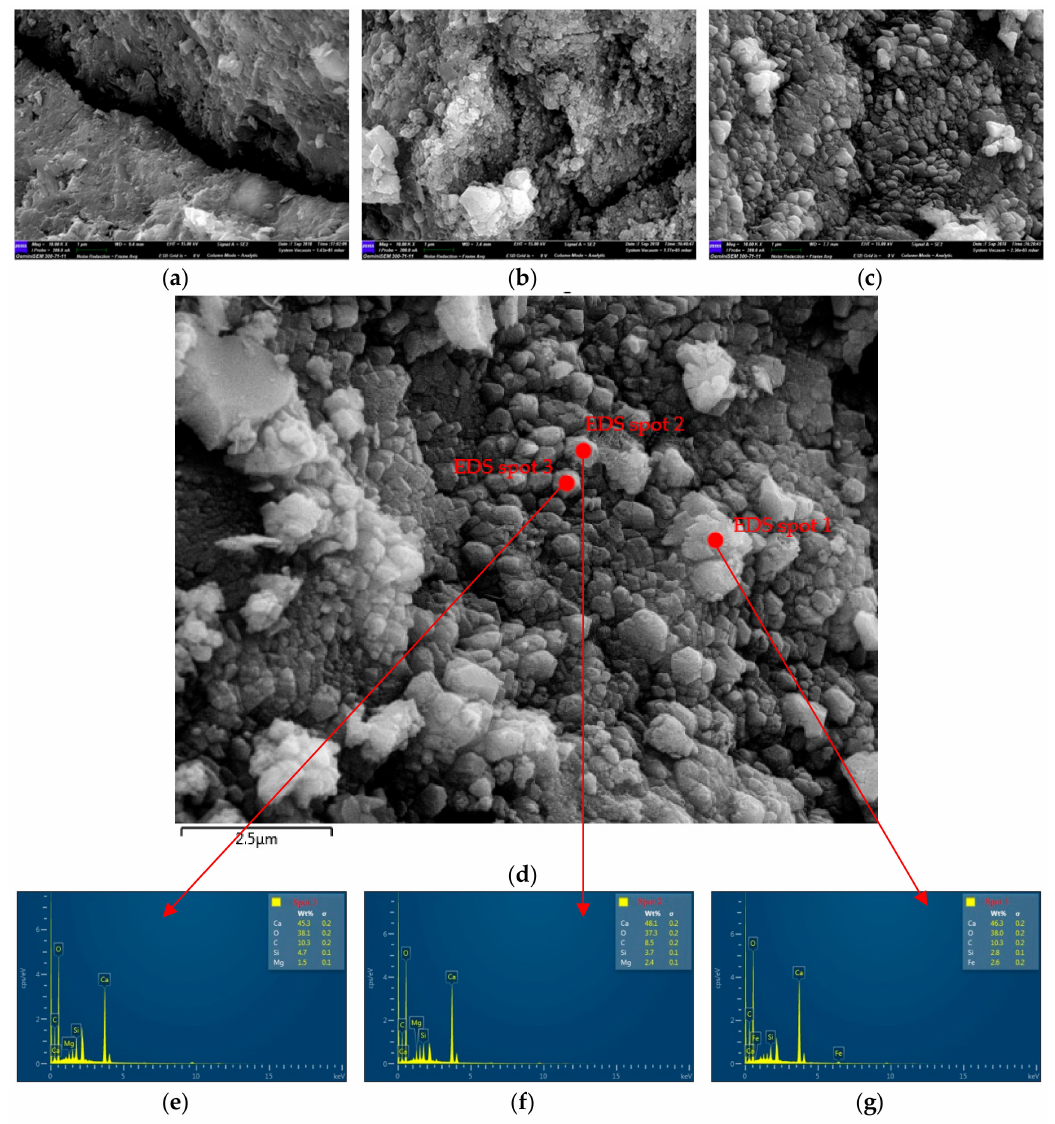
Figure 4. SEM-EDS images of the RMA surface: ( a ) the U-RMA surface; ( b ) the B-RMA surface; ( c ) the O-RMA surface; ( e – g ) EDS spectra of the particles in ( d